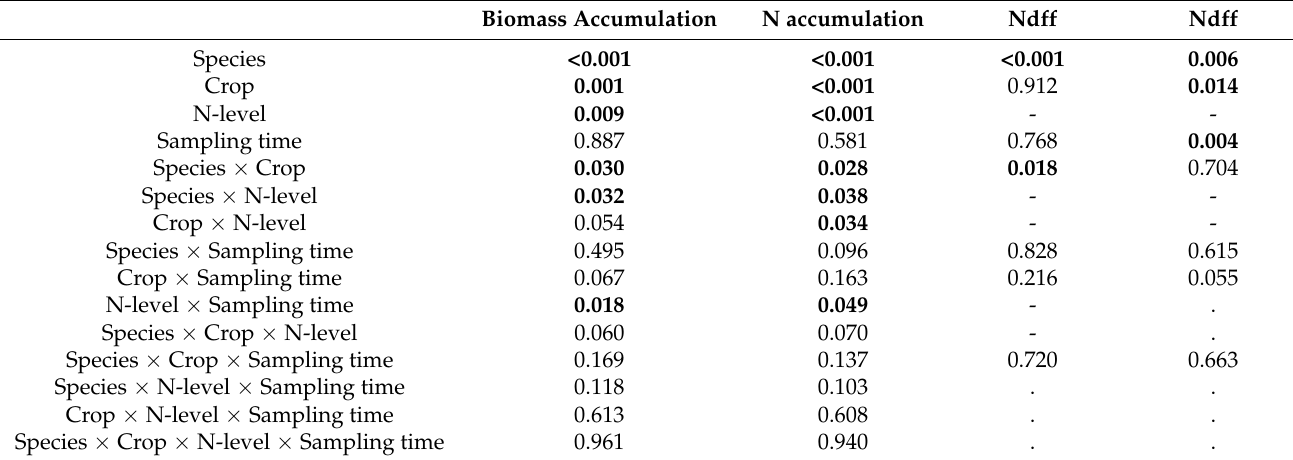
Table A2. p -values following analysis of variance of weed biomass and N accumulation (g m − 2 ) in dependency of the experimental factors weed species, crop, N-level and sampling time, and their interactions, and absolute (g m − 2 ) and relative (%) amount of N derived from fertilizer (Ndff) in dependency of weed species, crop and sampling time, and their interactions. p -values smaller 0.05 are marked in bold.